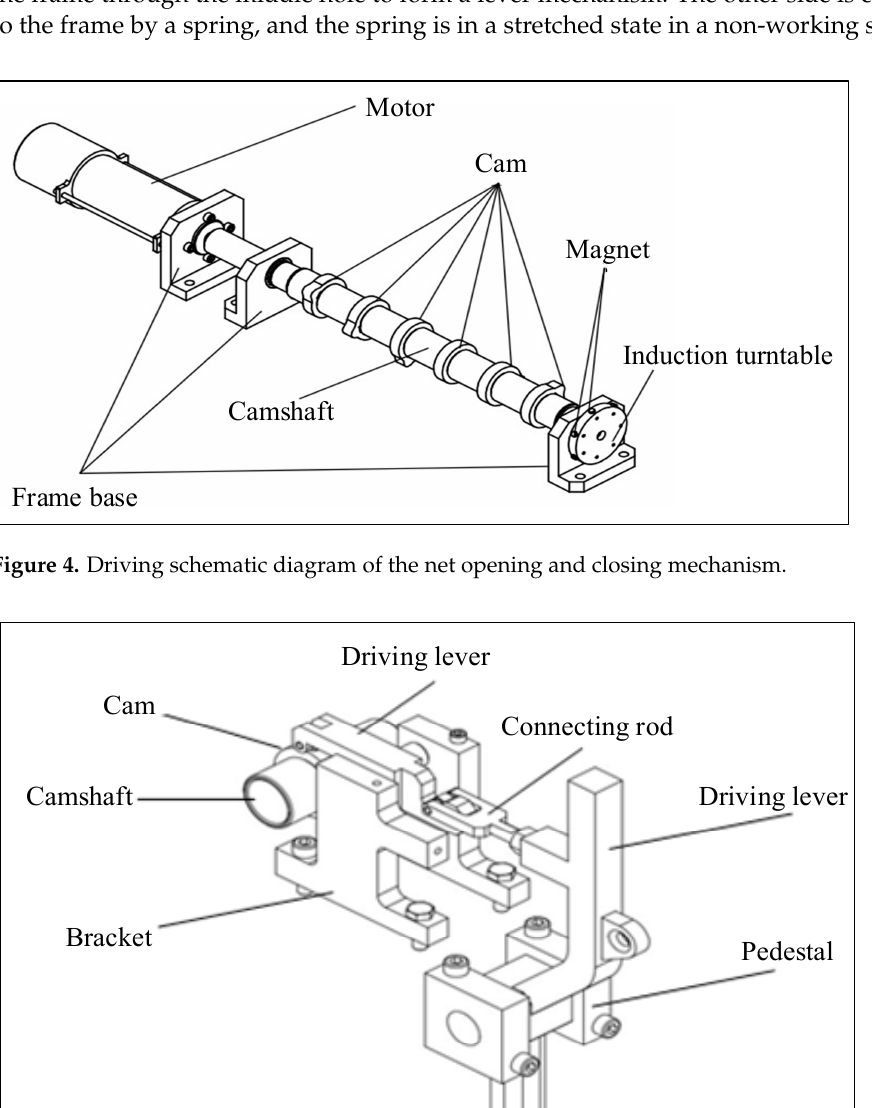
Figure 6. Schematic diagram of the induction device of the net opening and closing mechanism. 2.2. Temperature Retention System In order to maintain the original temperature of the zooplankton sample, a sample collection cylinder that can maintain temperature is designed as shown in Figure 7 (the left picture is the front and the right is the back). This part includes an outer frame, three insulation barrels, and a steel wire fixing seat. The sample collector is designed based on the principle of double-layer water bath insulation, and the base material adopts engi- neering plastics, which has a good insulation effect. The tail sample collection device uses plastic with poor thermal conductivity, uses a solenoid valve to trigger the collection of biological samples, and uses a water bath for sample insulation.